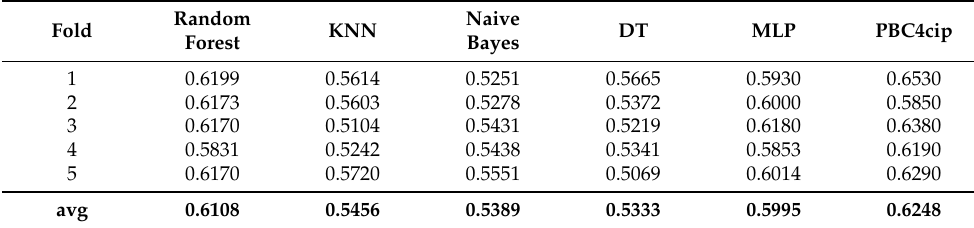
Table 4. Cross-validation AUC